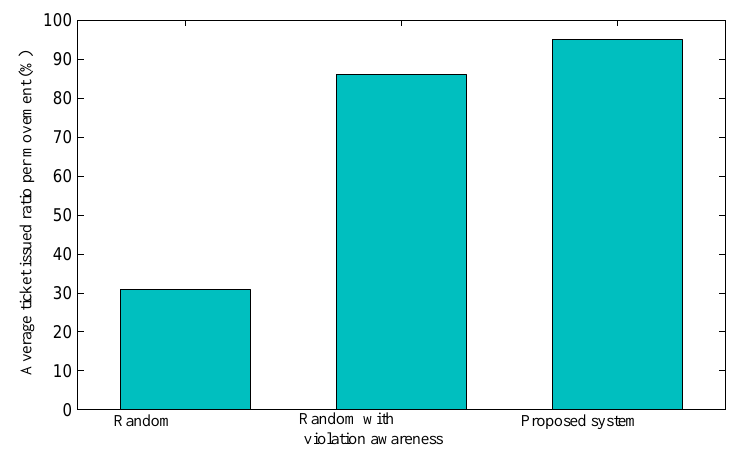
Figure 17. Average ticket issued ratio per a movement ( i.e ., from a cluster node to another cluster node) of officers in regions with high violation volumes.